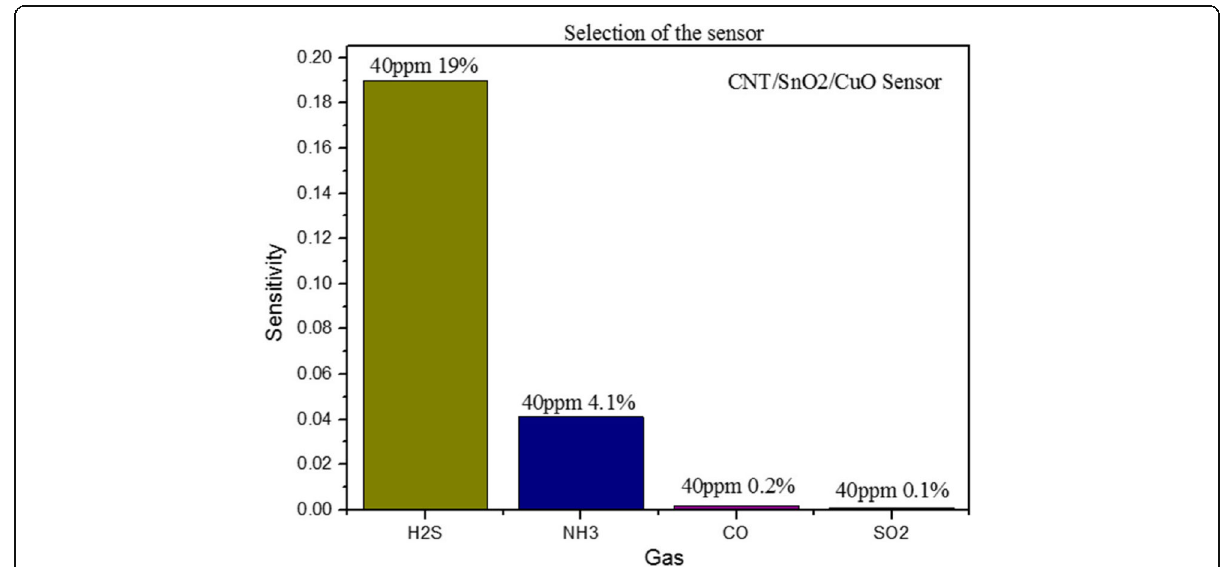
Fig. 8 Selectivity of the sensor in 40 ppm for H 2 S, NH 4 , CO, and SO